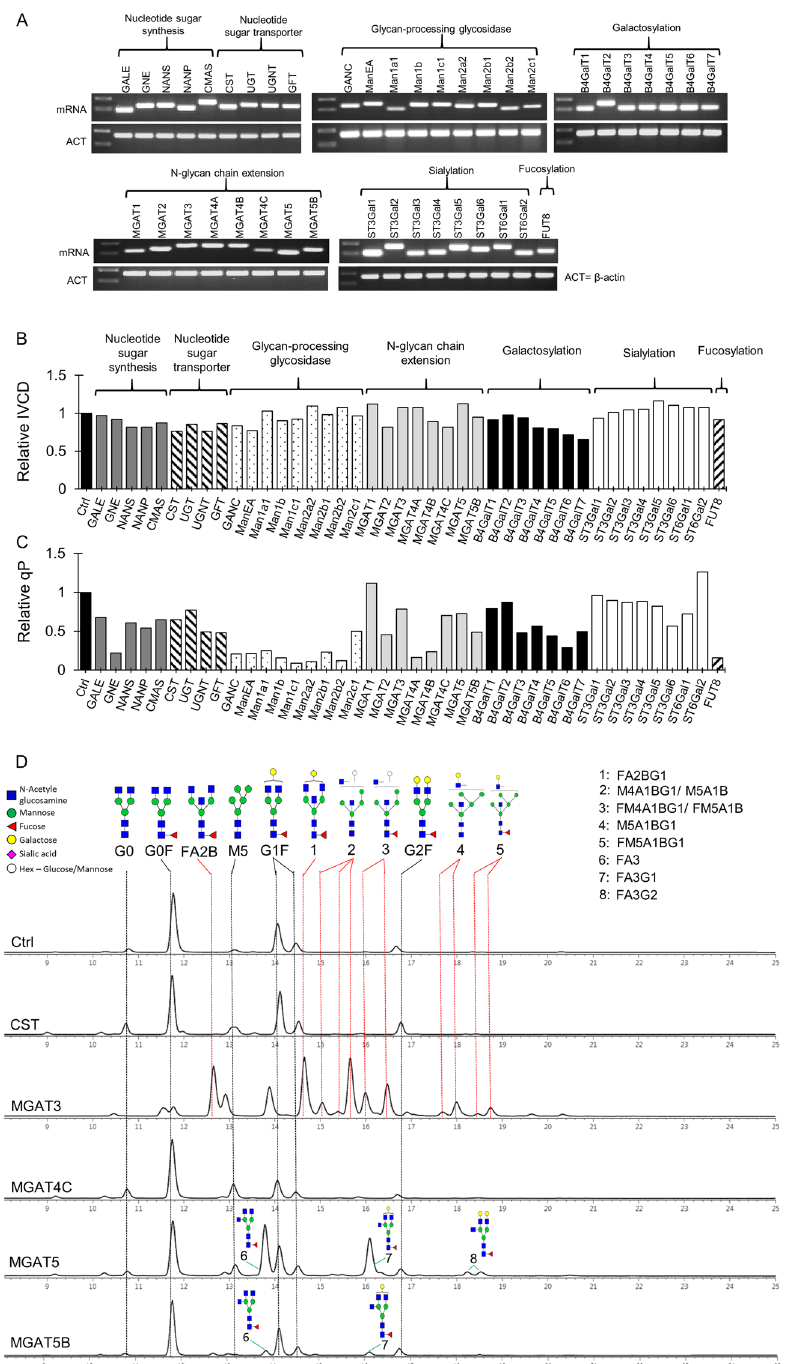
Figure 2. Impact of overexpressing individual human glycosyltransferases on growth, productivity and N-linked glycosylation of antibodies produced in stably transfected CHO cell pools. All stable pools were generated via RMCE. The control (Ctrl) pool expressed only IgG1 rituximab LC, HC and DsRed genes. Each of the other 42 stable pools co-expressed IgG1 rituximab genes, a specific human glycosyltransferase gene and DsRed. ( A ) RT-PCR analysis of human glycosyltransferase transcripts in different stable pools. β-actin (ACT) was used as an internal control. ( B – C ) Relative change in the integrated viable cell density (IVCD) and specific productivity (qP) in each stably transfected pool to the control. ( D – E ) Aligned HILIC chromatograms of N-linked glycans on antibodies in the control and representative stable pools which exhibited changes in the N-glycan profiles. Symbolic representation of the N-glycan structures was depicted for dominant peaks. Red dotted line indicated the N-glycan structures that were only found in MGAT3 sample. ( F – J ) Relative distribution of fucosylation, galactosylation, tri-antennary, sialylation and high-mannose on antibodies produced in different stable